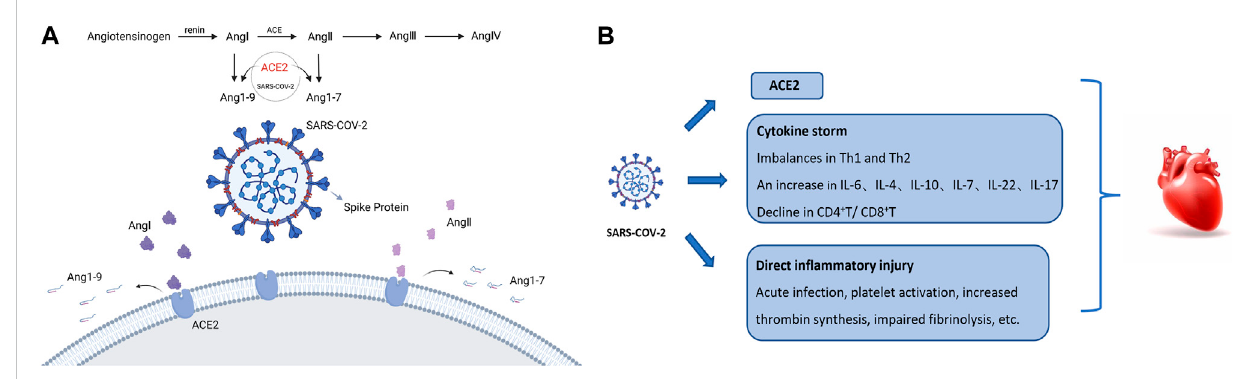
SARS-CoV-2 action on parts of the human body. (A) The mechanism of SARS-CoV-2 action with RAS; (B) Possible mechanism of SARS-CoV- 2 action on the heart. (ACE, Angiotensin converting enzyme; Ang I/II, angiotensin I/II; Ang1-7/Ang1-9,